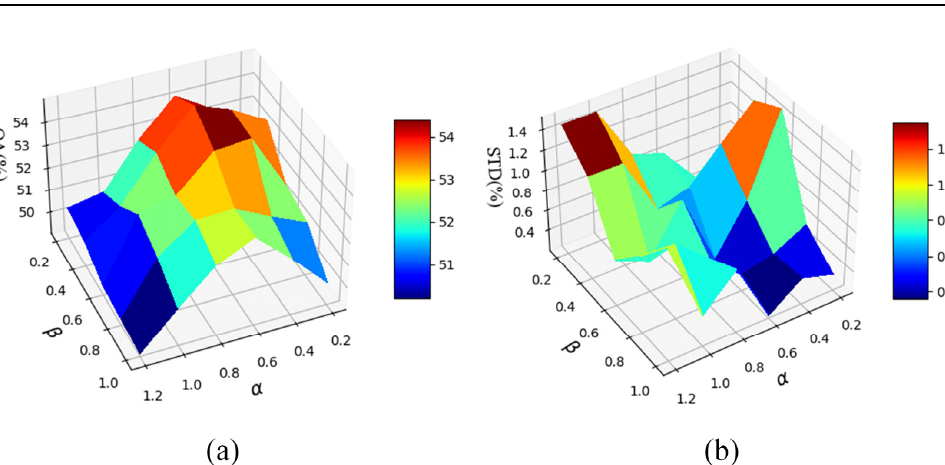
Figure 11. ( a ) shows the effect of hyperparameters α and β on the average accuracy of our proposed method. ( b ) shows the effect of hyperparameters α and β on the stability of our proposed method.